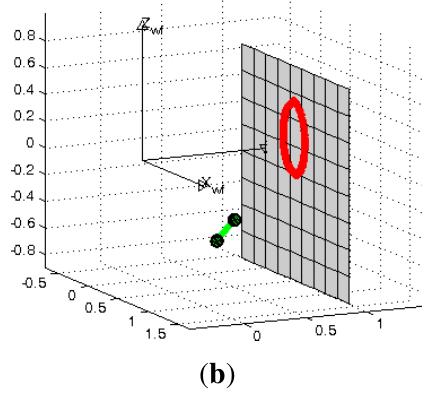
( a ) Calibration process; ( b ) Deformation of the conic shape depending on the laser